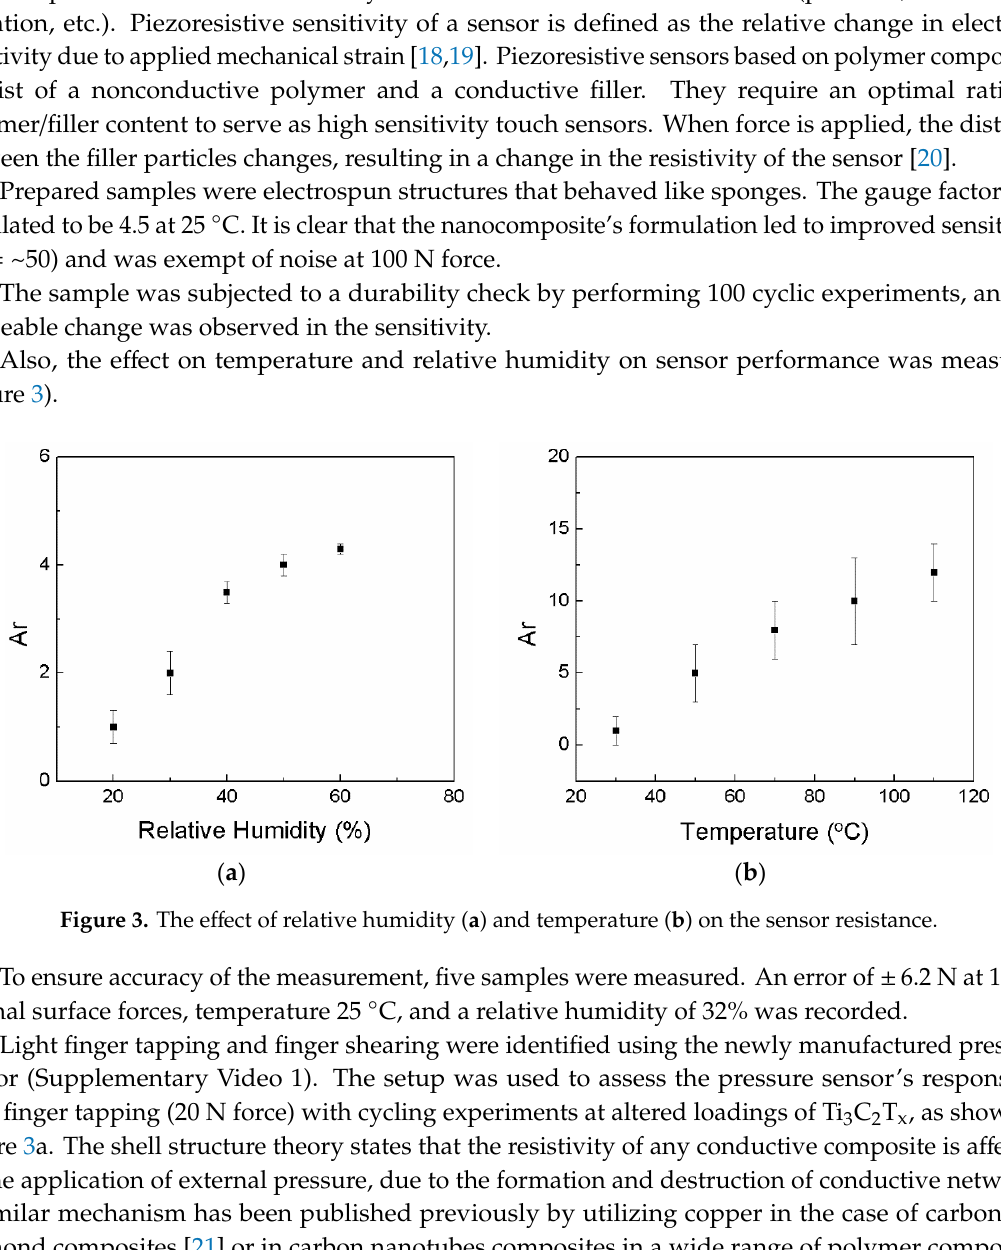
Figure 2. Electrical conductivity of electrospun coPA filled with Ti 3 C 2 T x.